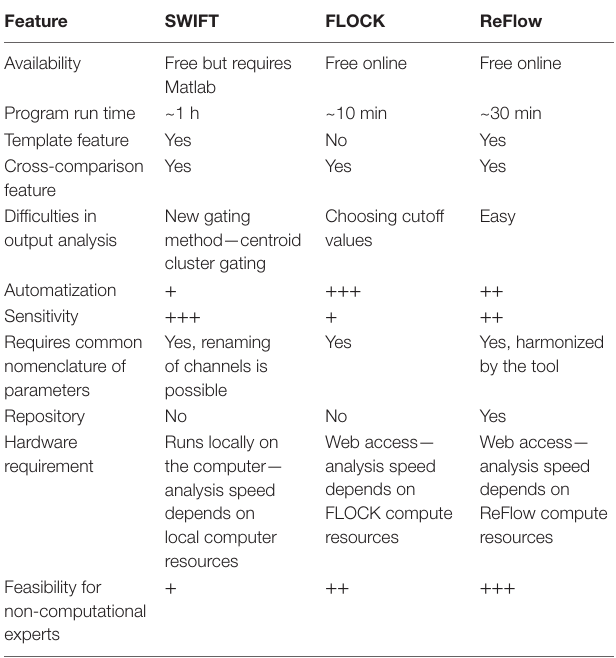
TaBle 1 | Features of the three software